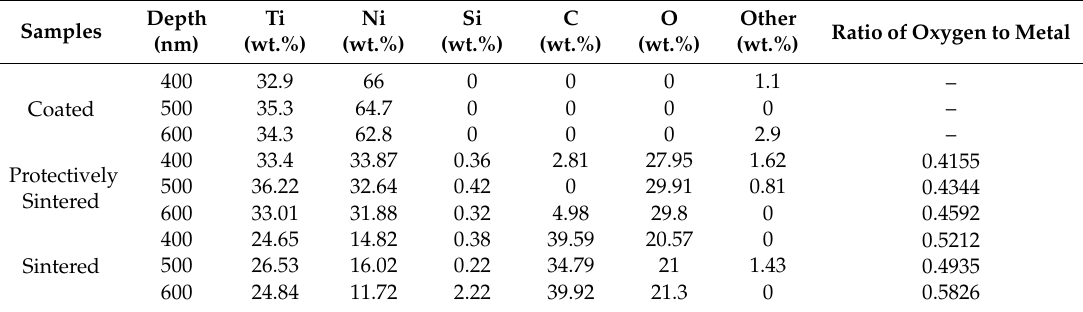
Table 1. The chemical contents of the coatings with different thicknesses and heat-treated states by energy dispersive spectroscopy (EDS) mapping.